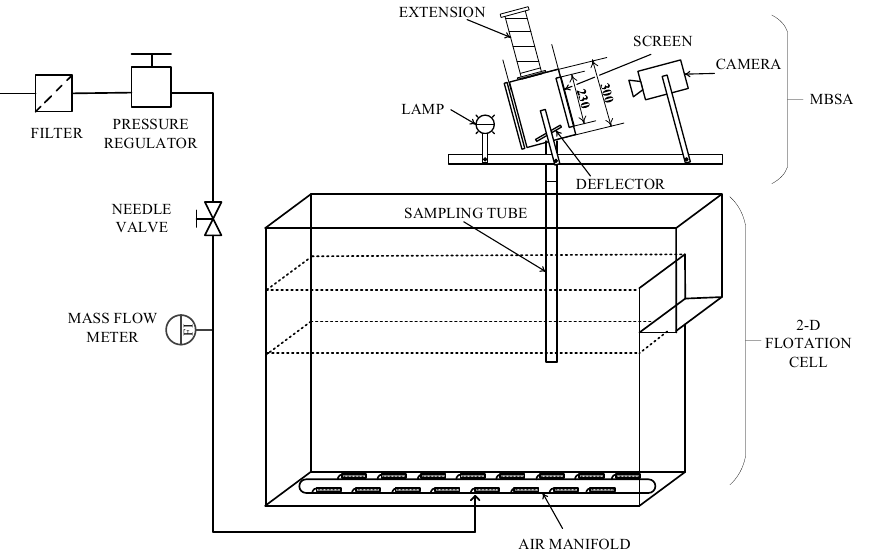
Figure 1. Two-dimensional flotation cell and installation of the McGill bubble size analyzer [29]. Four types of frothers were studied: methyl isobutyl carbinol (MIBC), AeroFroth ® 70 (Cytec, Woodland Park, NJ, USA), OrePrep ® F-507 (Cytec, Woodland Park, NJ, USA), and Flotanol ® 9946 (Clariant Mining Solutions, Louisville, KY, USA). AeroFroth ® 70 contains MIBC and diisobutyl ketone [30], OrePrep ® F-507 contains glycol and other non-hazardous components [30], and Flotanol ® 9946 corresponds to a 2-ethyl hexanol distillation bot- tom [31]. The experimental data were divided into training and testing datasets. Tables 1 and 2 present all the evaluated experimental conditions, including the distribution of the training and testing datasets. Frother concentrations of 0, 2, 4, 8, and 16 ppm were evaluated for all types of frothers, whereas 32 ppm was also assessed for AeroFroth ® 70, OrePrep ® F-507, and Flotanol ® 9946. The superficial gas rates were set to 0.5, 1.0, 1.5, 2.0, and 2.5 cm/s for MIBC, and to 0.4, 0.8, 1.2, 1.6, and 2.0 cm/s for the rest of the frothers. Conditions with high J G and low concentrations of MIBC favored the transition toward a churn-turbulent regime from an ellipsoidal regime, which was detected in the analysis. All tests were conducted at two locations in the flotation cell. From Tables 1 and 2, 104 experimental conditions were used in the training procedure and 72 for testing.